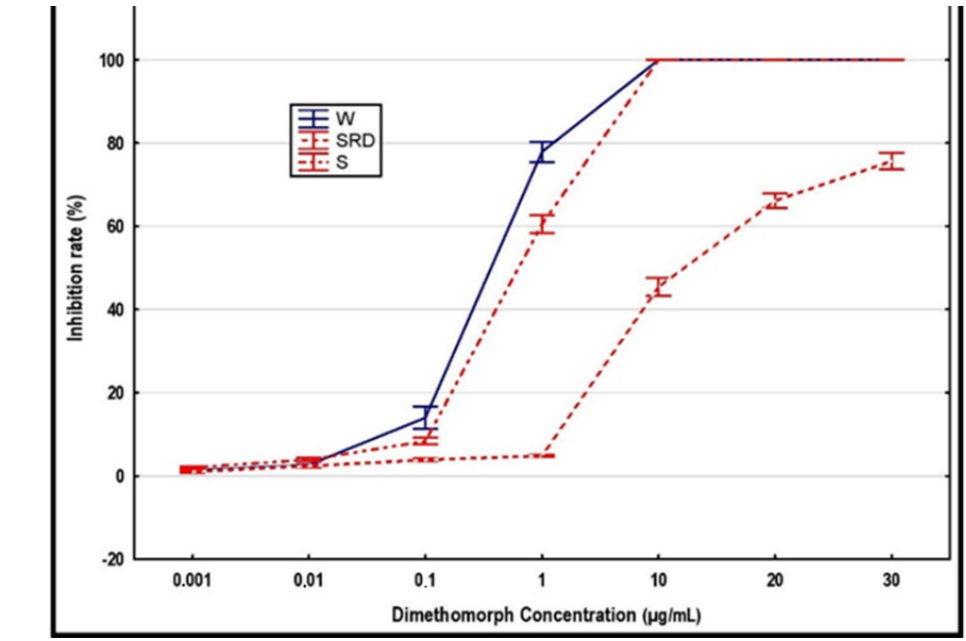
Figure 2. All tested isolates were organized into groups according to the host plant they were isolated from: S—strawberry, W—woody hosts. The group marked as SRD was created by isolates originating from strawberry plants which are obviously resistant to dimethomorph. The values of the mean and 95% confidence intervals are depicted . 0.1